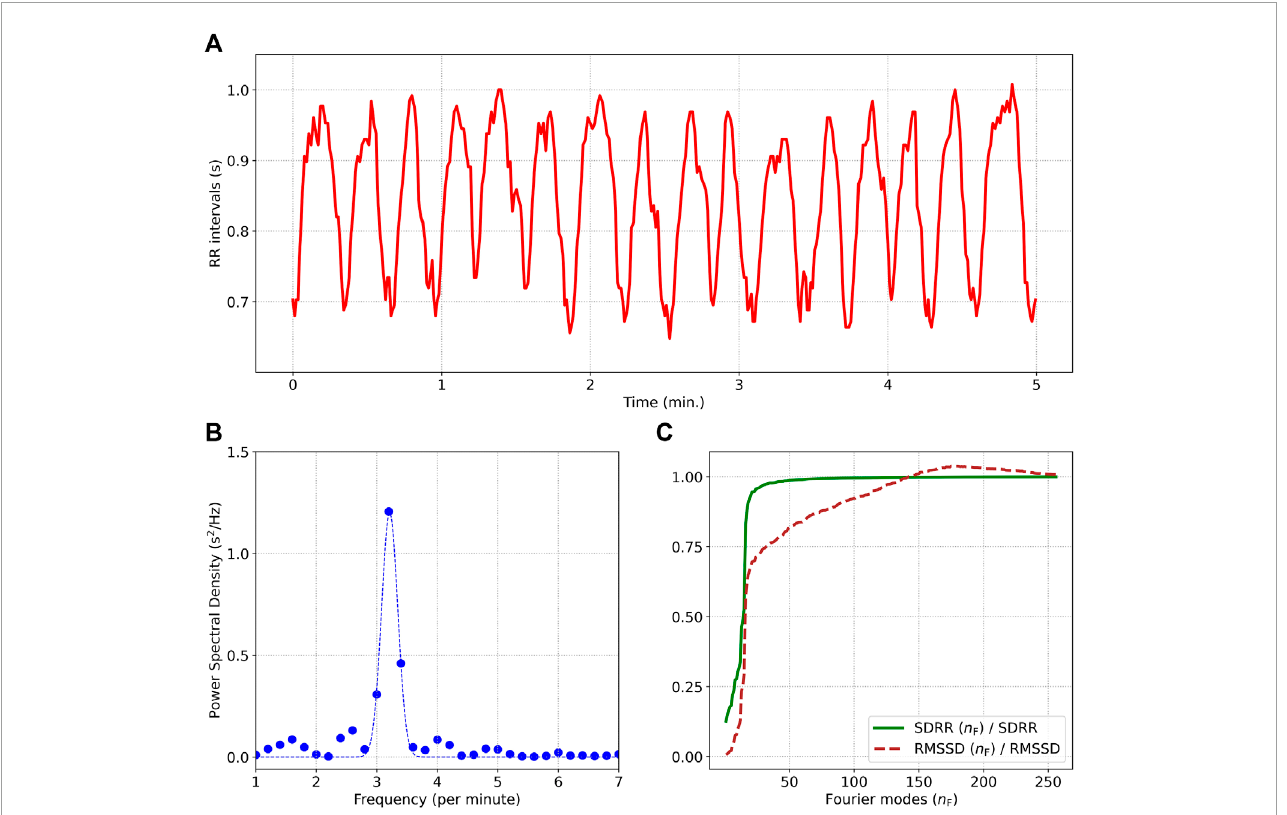
FIGURE 1 (A) describes a 5 min segment of the RR interval time series, from a subject practicing Chi meditation. (B) Shows the power spectral density showing strong respiratory sinus arrhythmia at a respiratory frequency of 3.2 min −1 . The ratios (RMSSD ( n F ) /RMSSD) and (SDRR ( n F ) /SDRR) computed from the first n F Fourier modes are displayed in (C) . Many more Fourier modes need to be included for the computation of RMSSD ( n F ) compared to SDRR ( n F ) since RMSSD preferentially weights the higher frequency